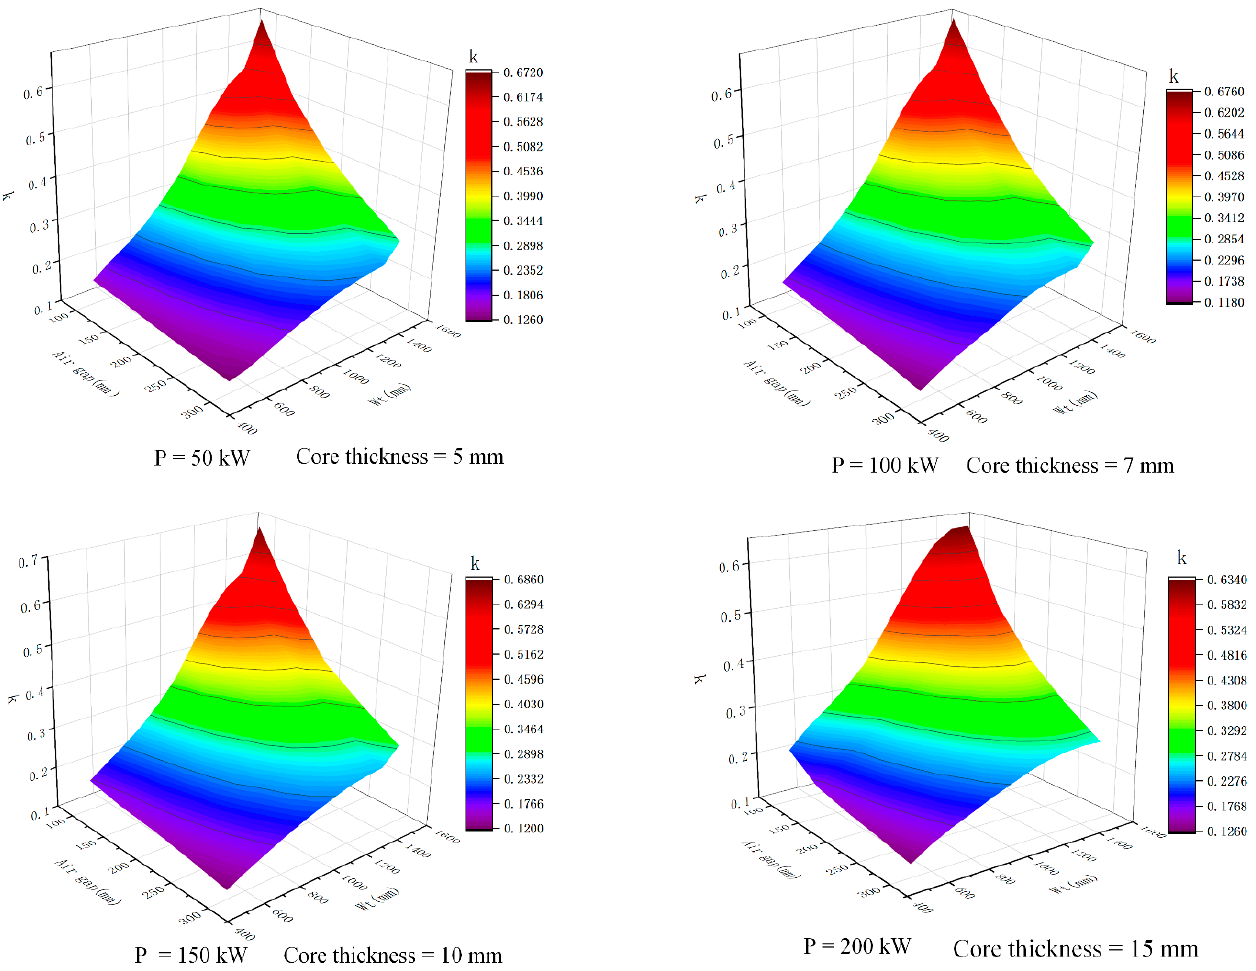
Figure 6. Coupling coefficient at different powers, air gaps, and W t measurements.